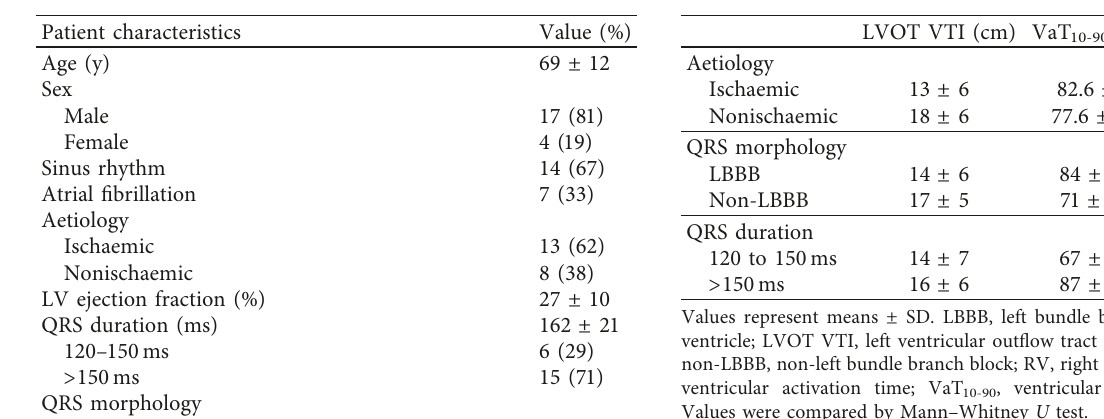
Values were compared by Mann–Whitney U